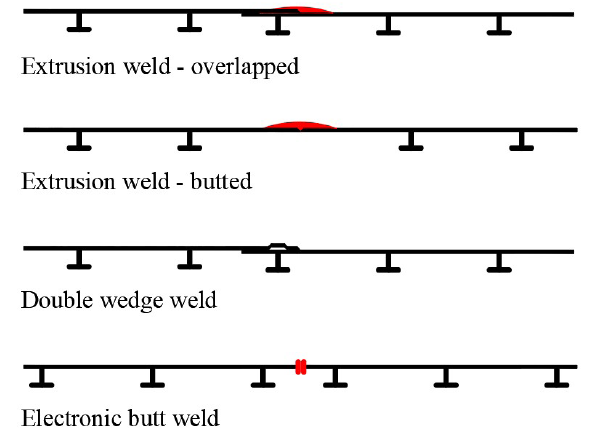
Figure 5: HDPE weld